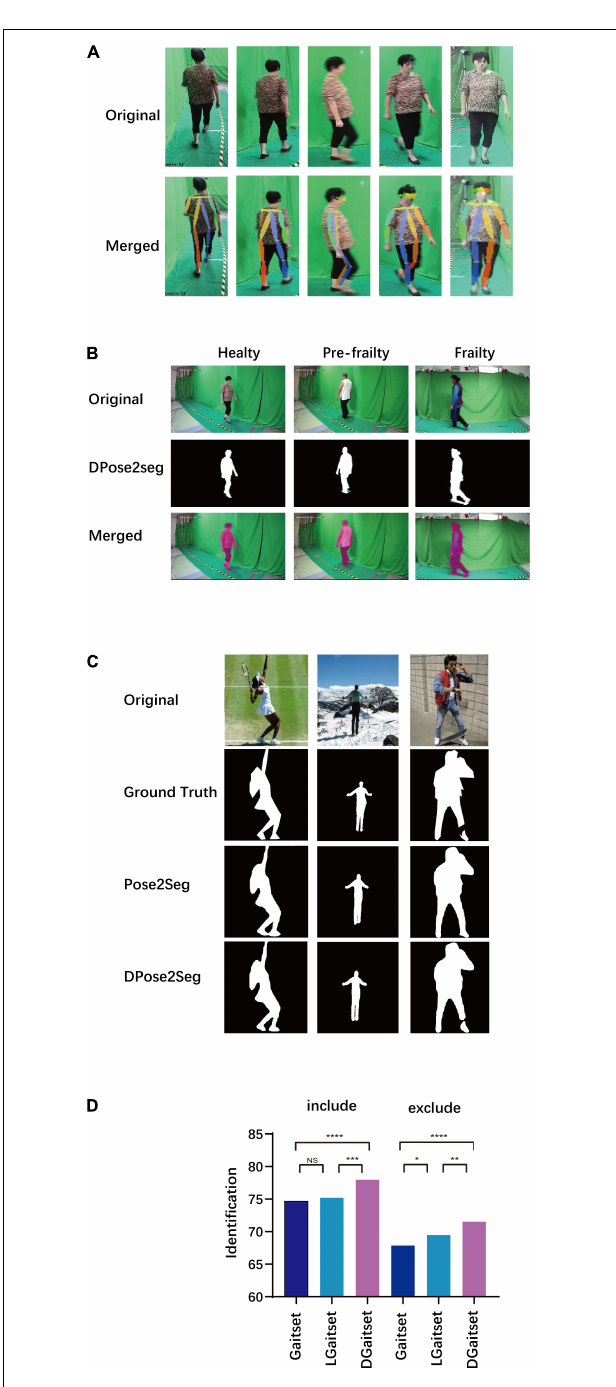
FIGURE 5 | Results of key point extraction, silhouette segmentation, and gait feature extraction. (A) Sample of body key points extraction (original image and visualisation of key points parameters merged with original). (B) Sample of silhouette segmentation in current dataset. (C) Sample of silhouette segmentation in COCO dataset. (D) Results of Gait identification task via different method. Include: validation set includes the gait sequence filmed from the same camera stand with the probe. Exclude: validation set excluding gait sequence filmed from the same camera stand with probe; NS, P -value for difference of successful identification ratio between methods ≥ 0.05; * P < 0.05; ** P < 0.01; *** P < 0.005; **** P <